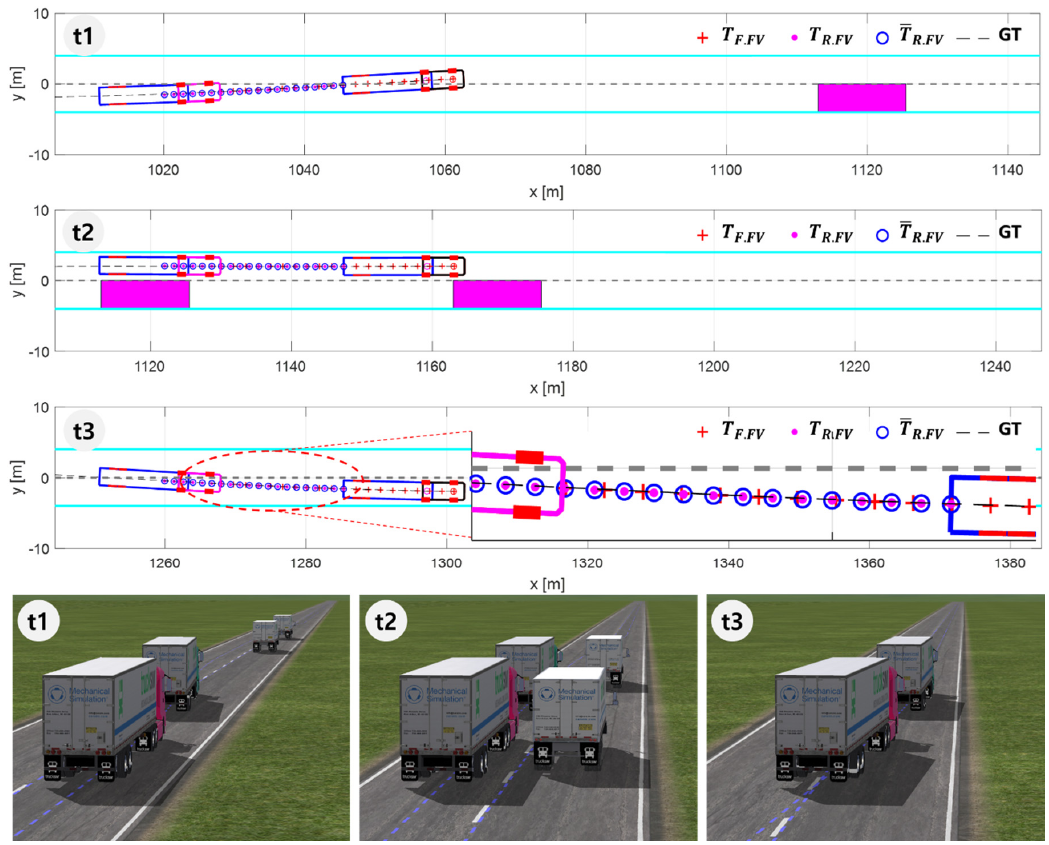
Figure 20. The simulation results for Scenario S3. At t1, LV finds stopping vehicles and begins to change lanes. At t2, the platoon is passing by them. At t3, the platoon has overtaken stopped vehicles and is returning to its original lane. Sensors 2020 , 20 , x